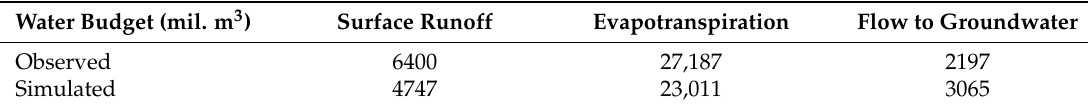
Table 5. Long-term average annual water budget